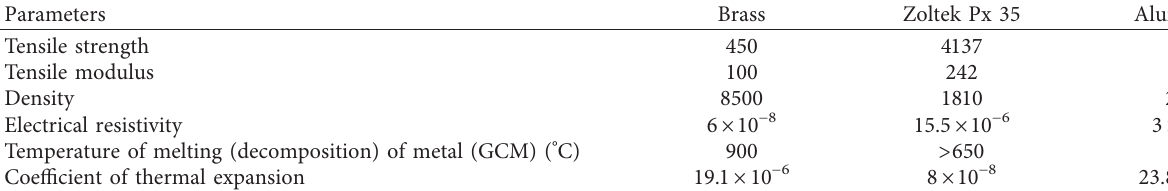
Table 1: Properties of graphene-composite metal antennas [3].